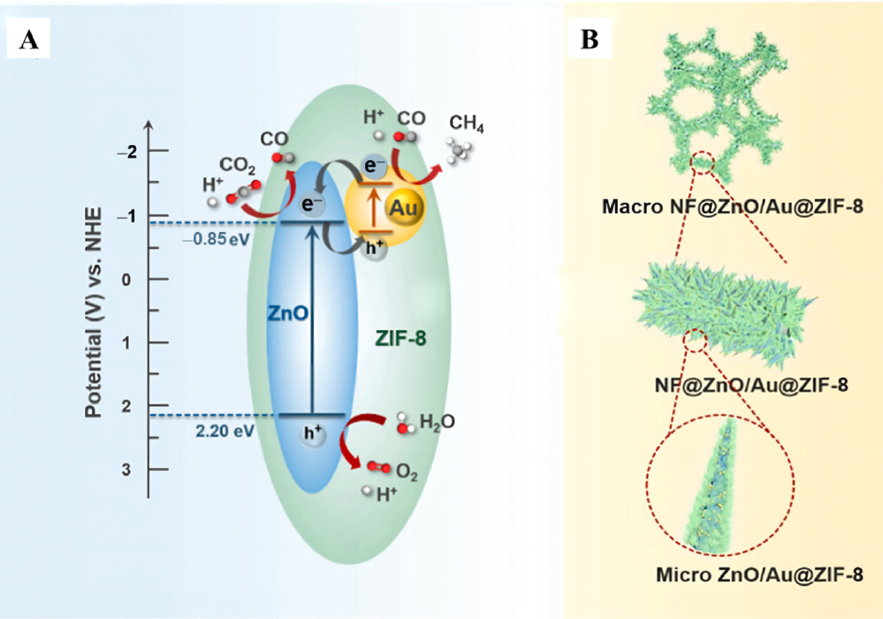
Figure 14. ( A ) Illustration of the band structure and charge transfer process of NF@ZnO/Au@ZIF-8 catalyst under UV − vis light. ( B ) The structural diagram the monolithic NF@ZnO/Au@ZIF-8 photocatalyst [100].